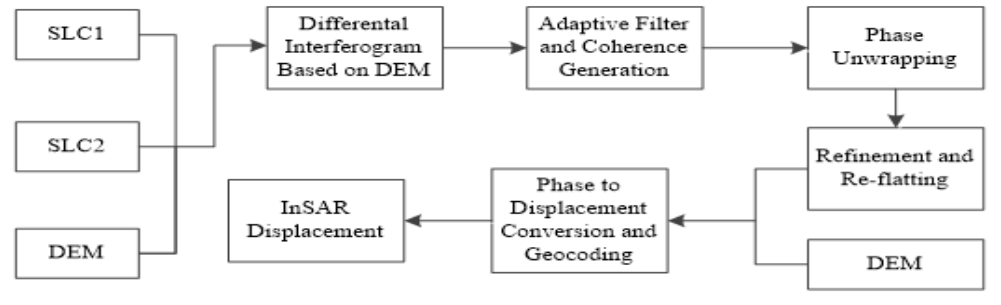
Figure 1: Processing of D-InSAR in Sarscape